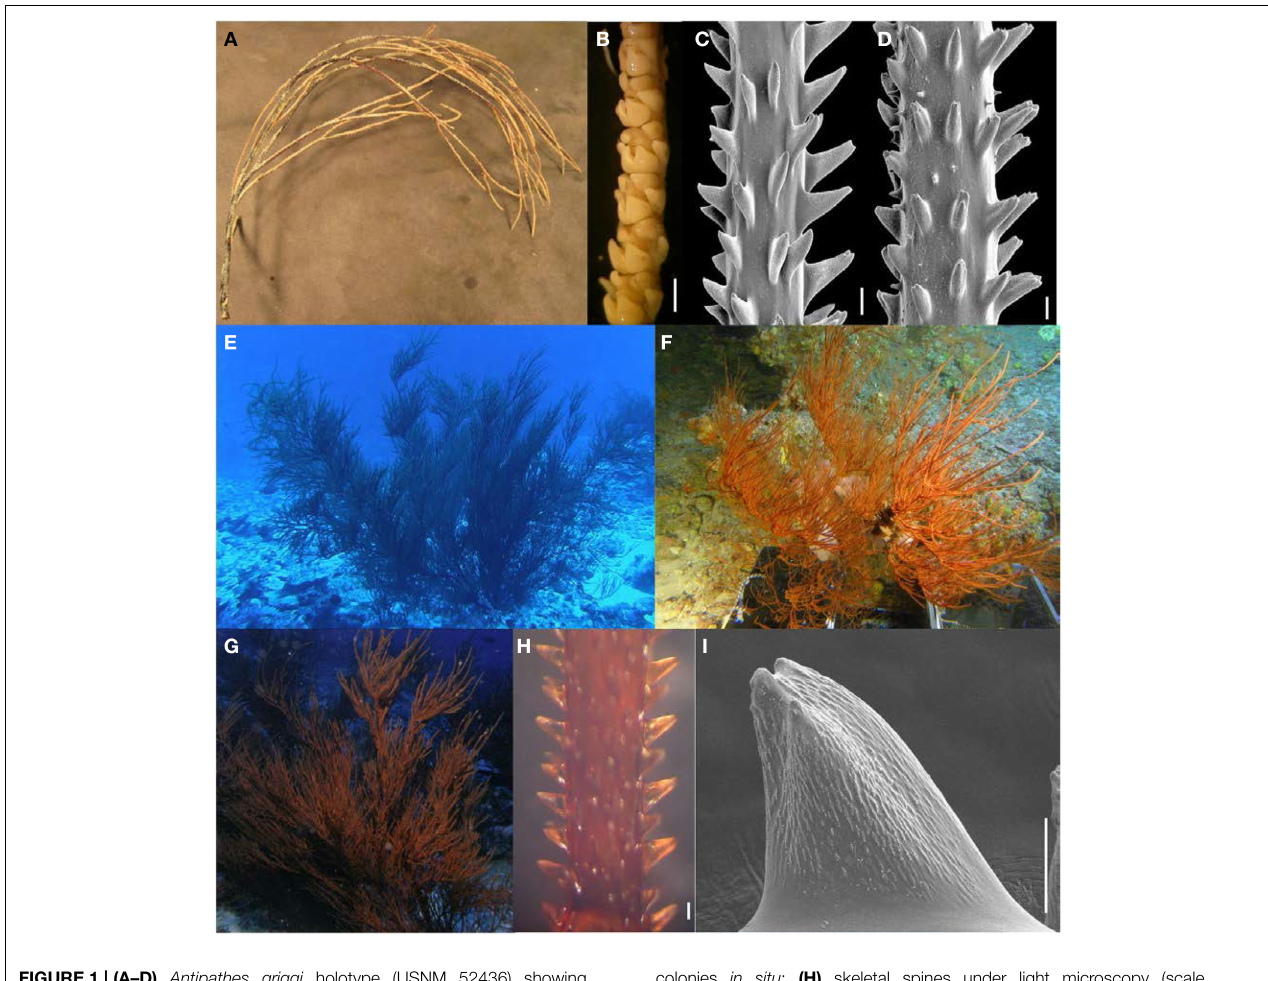
colonies in situ ; (H) skeletal spines under light microscopy (scale bar = 100 μ m); (I) close-up of polypar spine under SEM (scale bar = 50 μ m). (Photos courtesy of E,G Tony Montgomery, and F